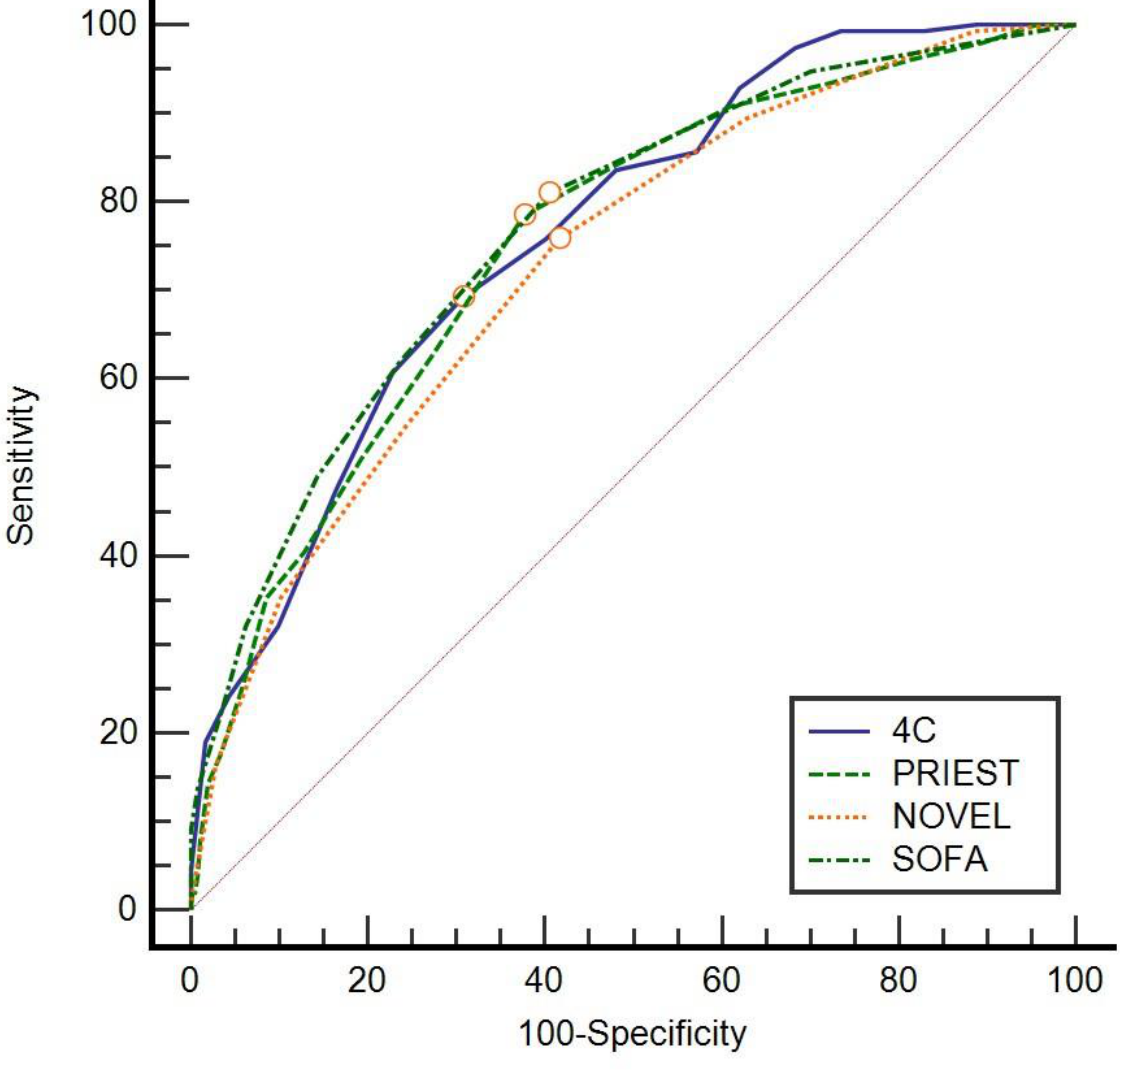
Figure 2. Receiver operator characteristic (ROC) curves for the ISARIC 4C, PRIEST, NOVEL and SOFA scores.